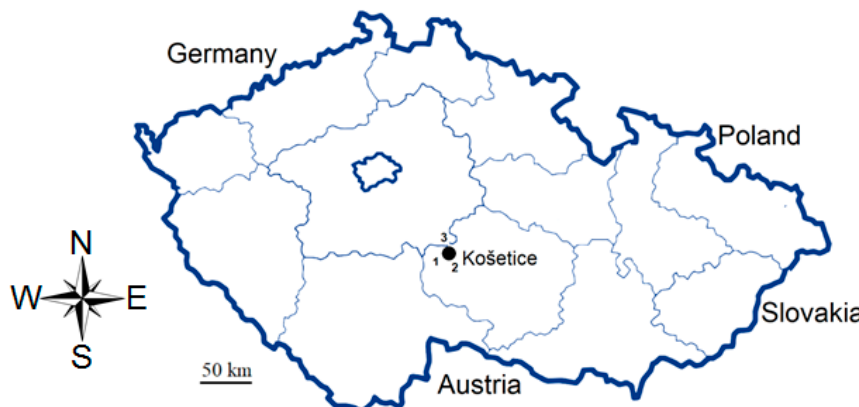
Figure 1. Location of the sampling site National Atmospheric Observatory Košetice (NAOK) within the Czech Republic. The location of potential polycyclic aromatic hydrocarbon (PAH) sources cities 1 (Lukavec), 2 (Košetice), and 3 ( Č echtice) are indicated in the map [20]. Filters sampling was done every 3 days using LVS3/MVS6 active samplers (Leckel, Germany). The sampling took 24 h with a flow rate of 2.3 m 3 ·h − 1 . The samples were collected onto quartz filters (QF) (for sampling particulate PAHs) and polyurethane foam (PUF) discs (for sampling gaseous PAHs). The blanks were used to ensure QA/QC of the entire process [21,22].